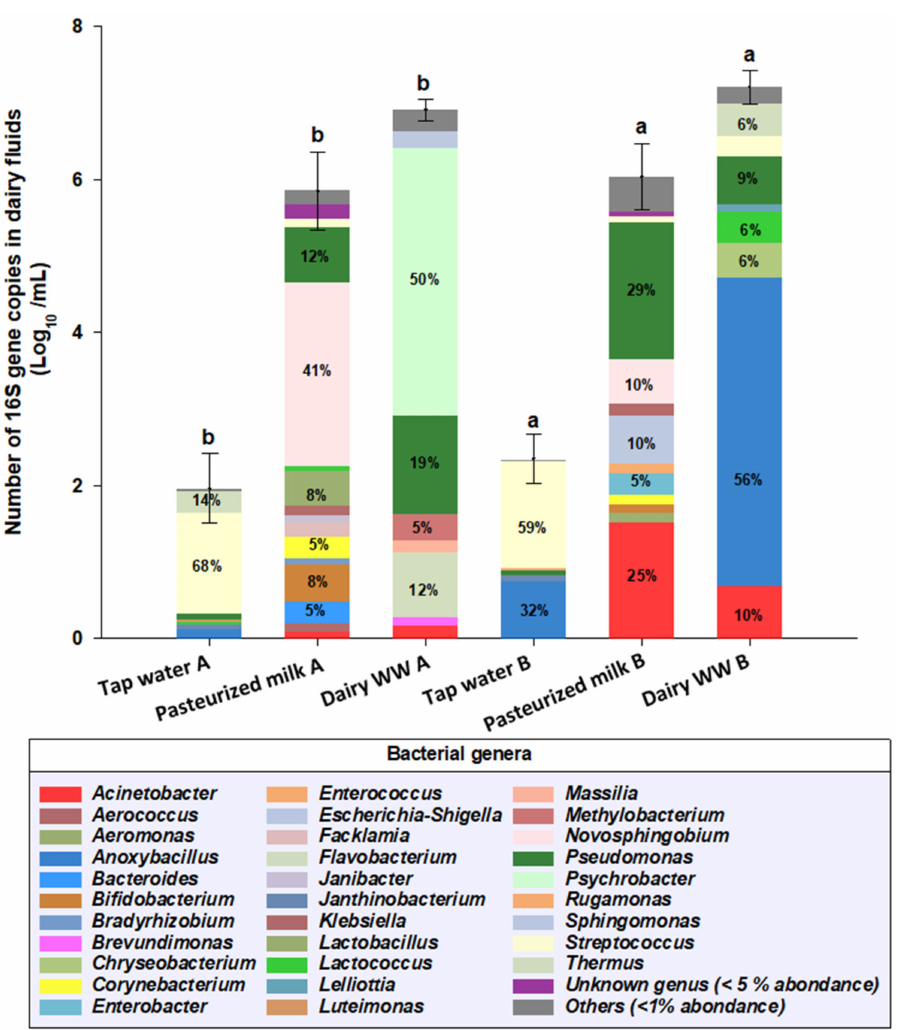
Figure 1. Bacterial communities found in dairy wastewater (WW) recovered from pasteurizers, tap water and pasteurized skim milk of two Canadian dairy plants (A and B). The bar length represents the number of 16S gene copies of the bacterial genus in these fluids and the percentages indicate the proportion of the specific bacterial genus. Values below 4% were not presented. For the same effluent (tap water, pasteurized milk, or dairy WW) different letters indicate significant differences (Student’s t -test, p < 0.05, n = 2, ± standard deviation